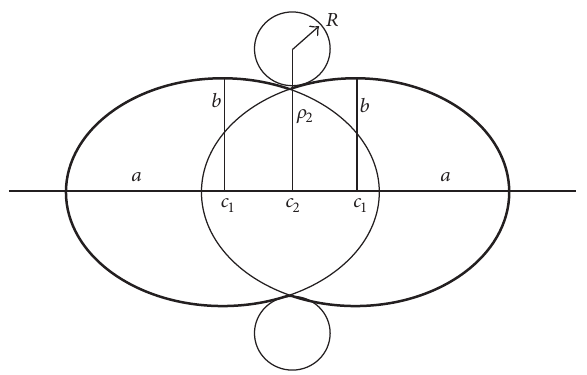
Figure 1: Parameterizations of nuclear shape in two cluster struc-